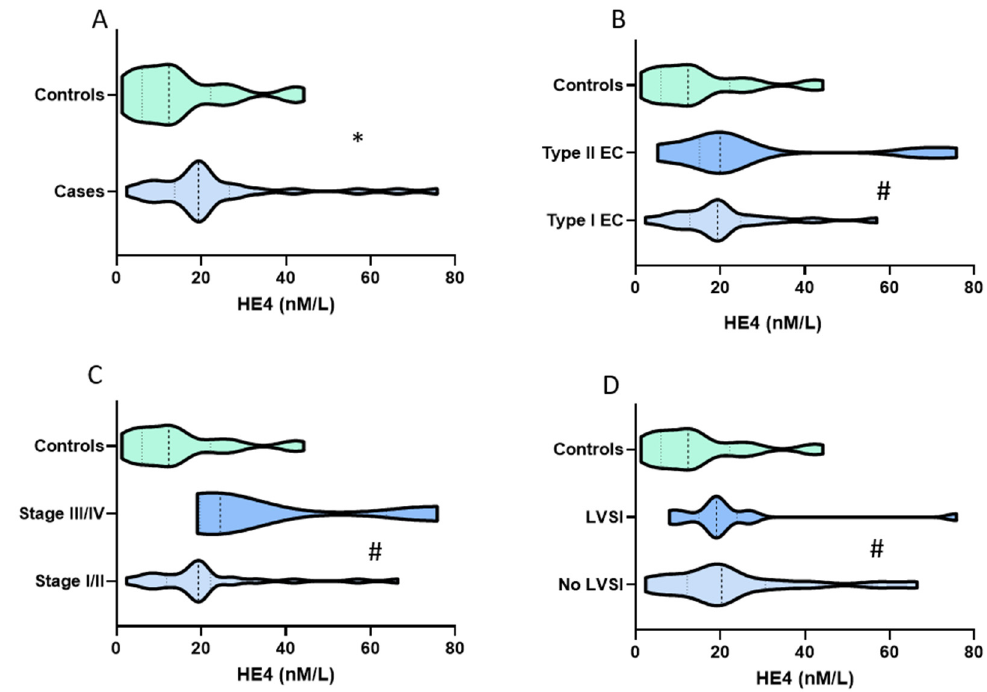
Figure 3. Violin plots comparing urine HE4 by case-control status ( A ), Bokhman group ( B ), FIGO stage ( C ), and absence or presence of lymphovascular space invasion ( D ). Statistical significance was determined by the nonparametric Mann–Whitney U tests for relevant dichotomous groups. The p -values portrayed with * indicate p < 0.05 while # indicates p ≥